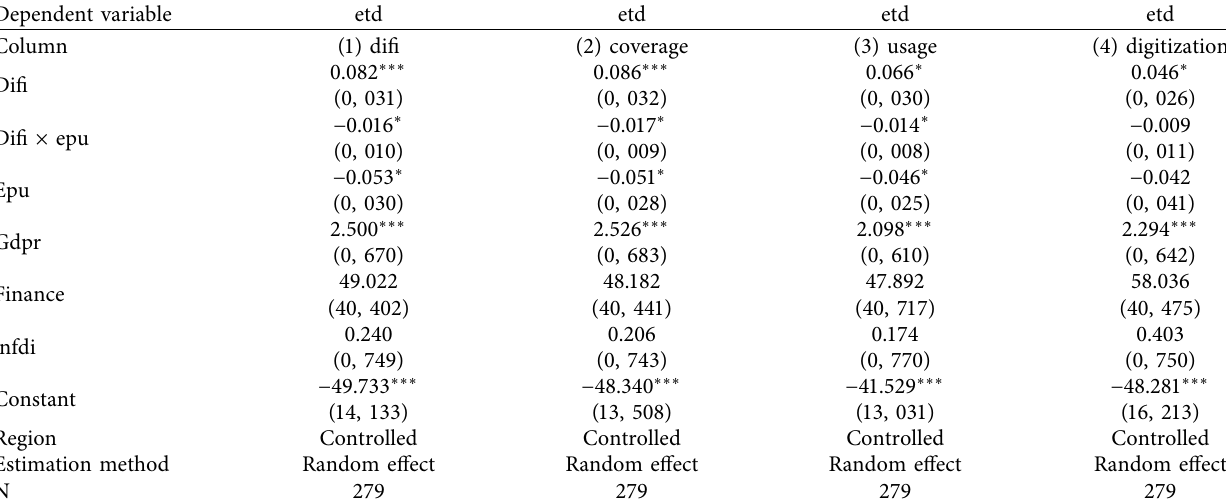
Table 6: Moderating effect of economic policy uncertainty.